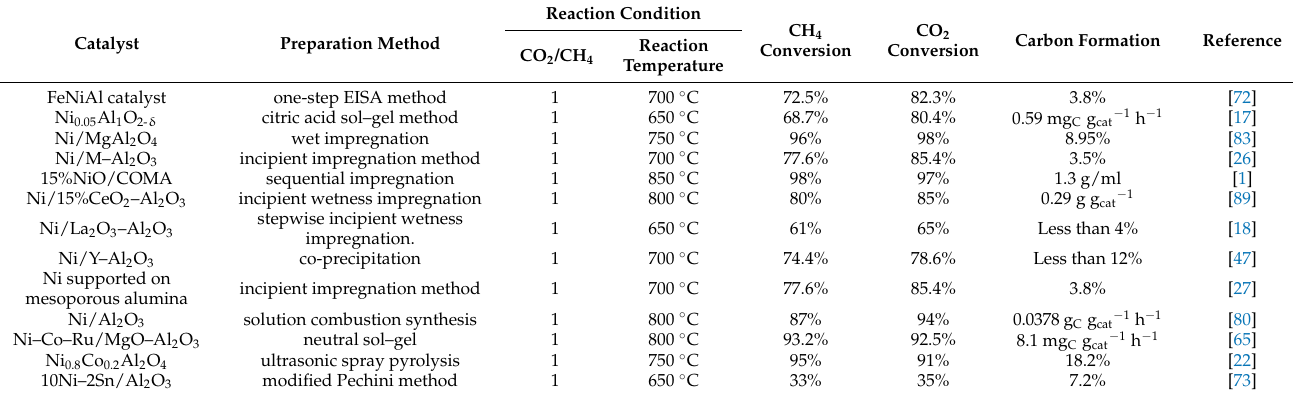
Table 1. Summary of the Ni/Al 2 O 3 catalysts in DRM